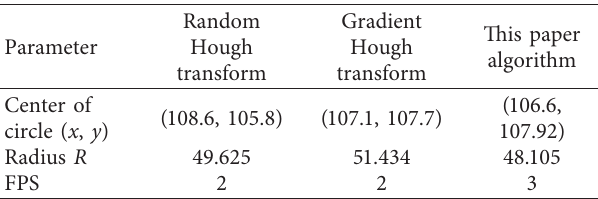
Table 6: Statistics table of size detection results of compensation hole of automobile brake master